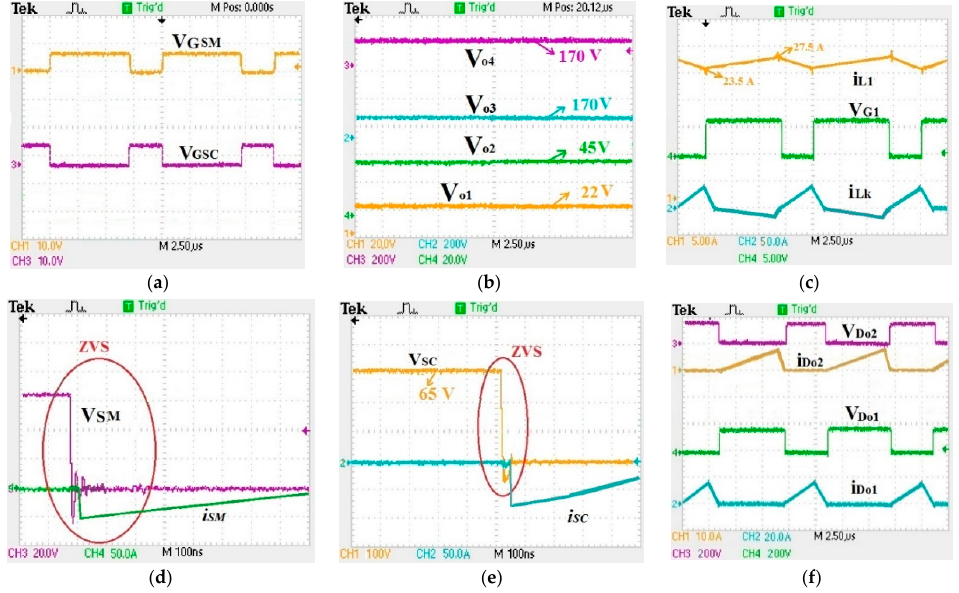
Figure 12. Experimental results for rated power when V in = 20 V, D = 0.65, and P out = 1000 W. ( a ) Gate-